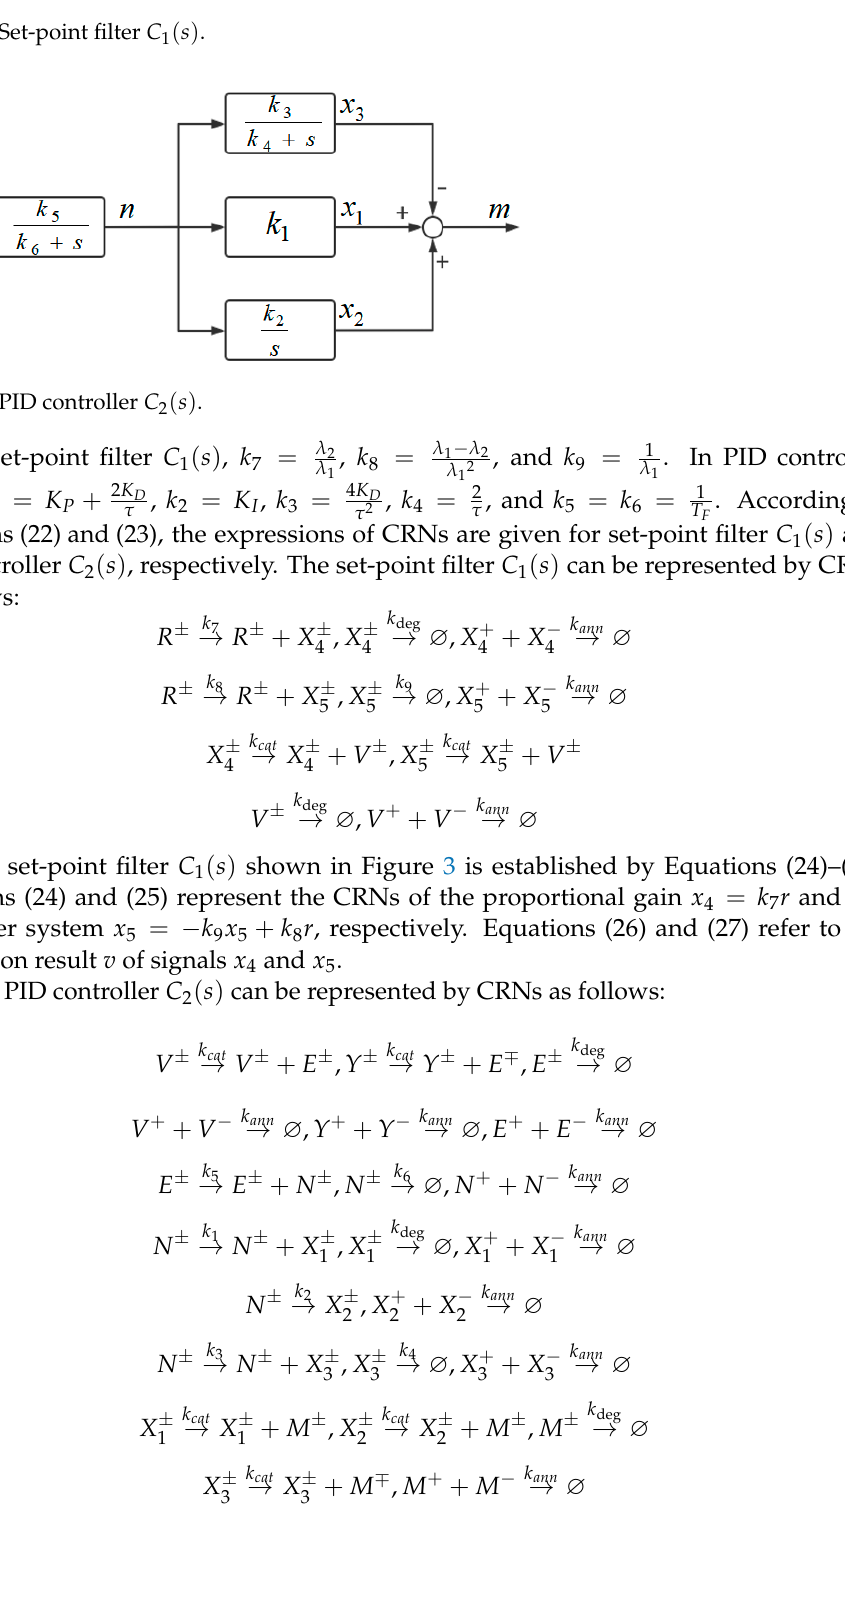
Figure 3. Set-point filter C 1 ( s ) .